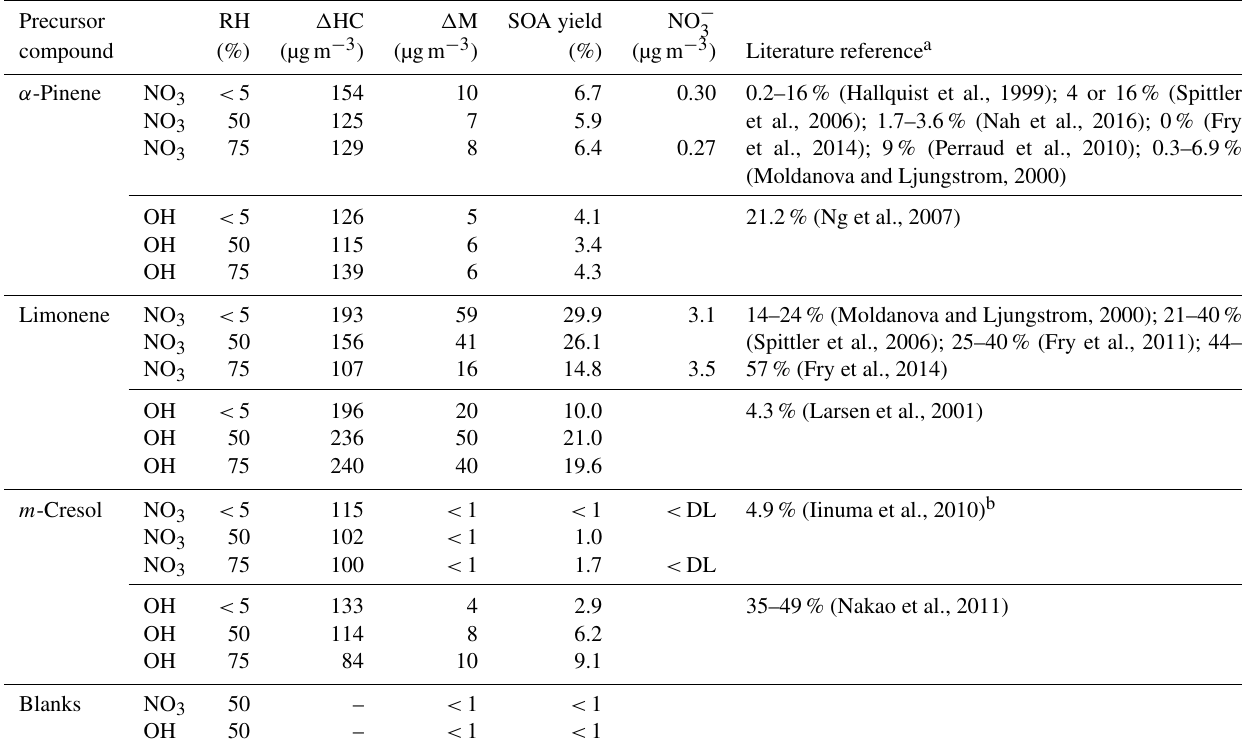
Table 1. Experiments conducted for the NO 3 - and OH-radical-initiated oxidation of α -pinene, limonene, and m -cresol. All reactions were conducted with 60ppbv initial hydrocarbon concentration at T = 293 K and in the presence of (NH 4 ) 2 SO 4 / H 2 SO 4 (pH = 4 at 50% RH). OH-radical experiments were done in the presence of 10ppbv